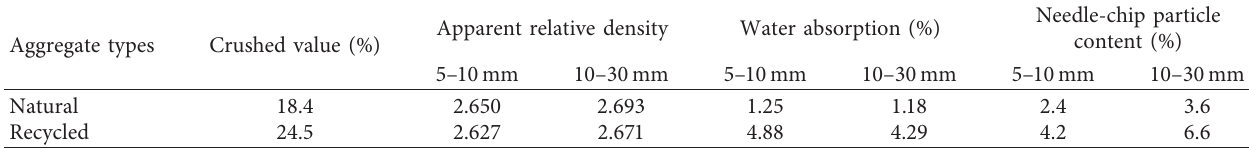
Table 1: Physical and mechanical performance of coarse